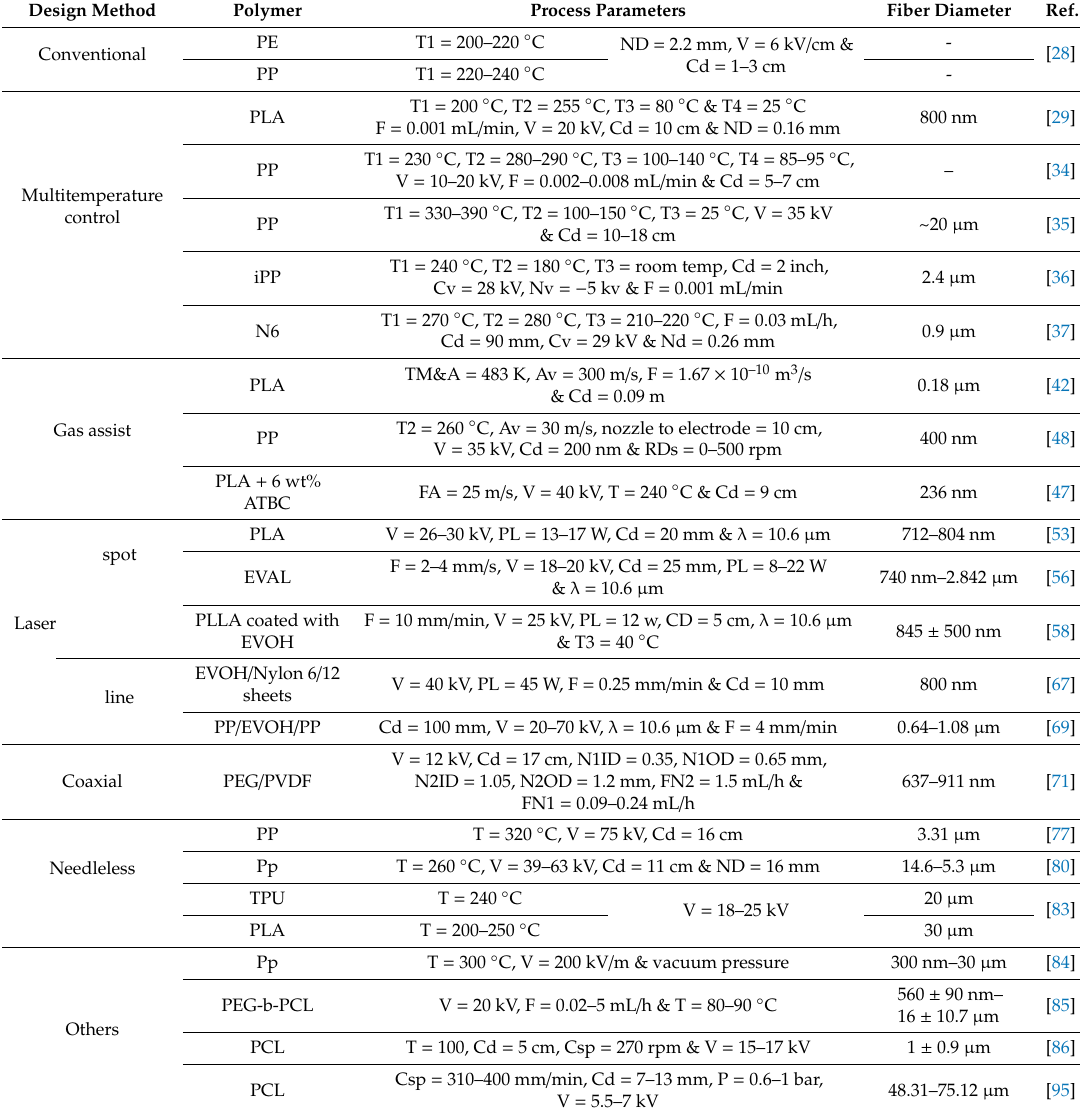
Table 1. Di ff erent approaches to melt electrospinning with their processing